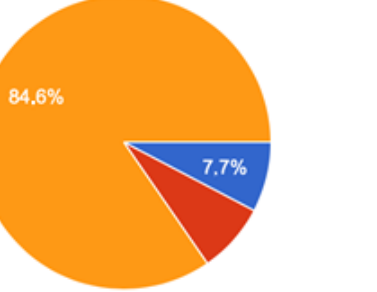
Figure 1. Procedures associated with PMVT. PMVT: Portomesenteric vein thrombosis; RYGB: Roux-en-Y gastric bypass; LSG: sleeve gastrectomy procedures; BPD: biliopancreatic diversions LAGB: Laparoscopic Adjustable Gastric Banding;